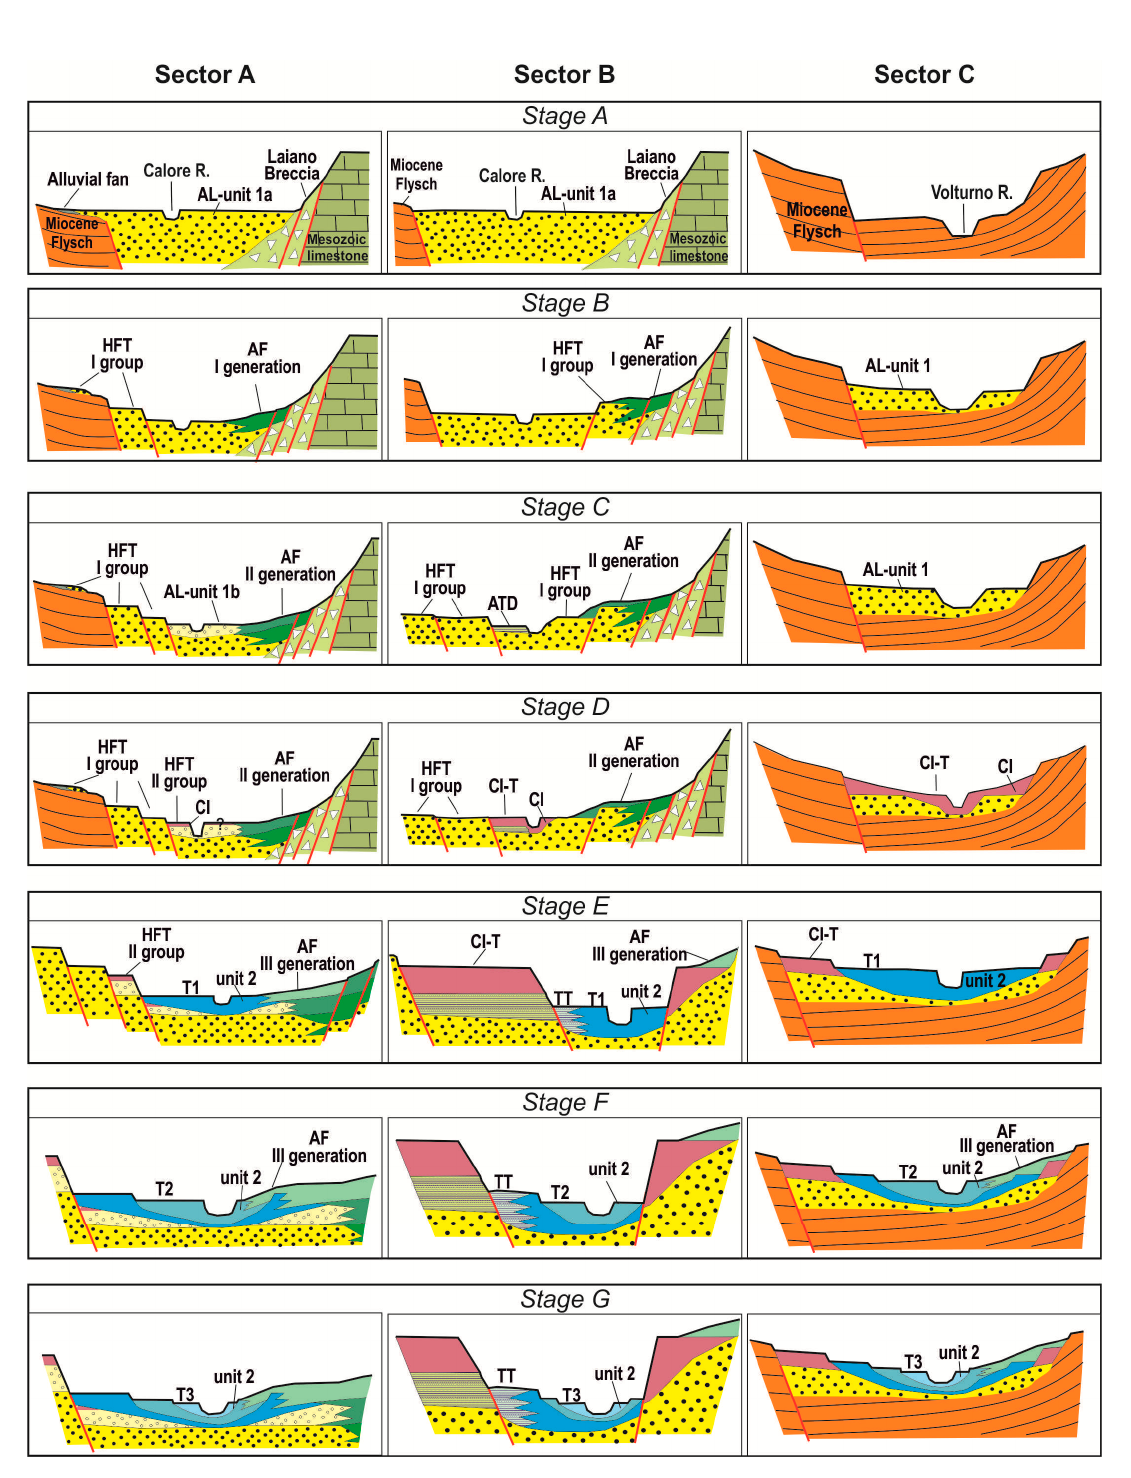
Figure 17. Schematic cross sections (not in scale) illustrating major morpho-evolutive steps (Stages A–G) of the Quaternary landscape evolution reconstructed for the middle Volturno and lower Calore valleys in sectors A, B, and C. The sections refer to the final phase of each stage. From Stage E to Stage G, the cross sections show a zoom of the valley floor areas.